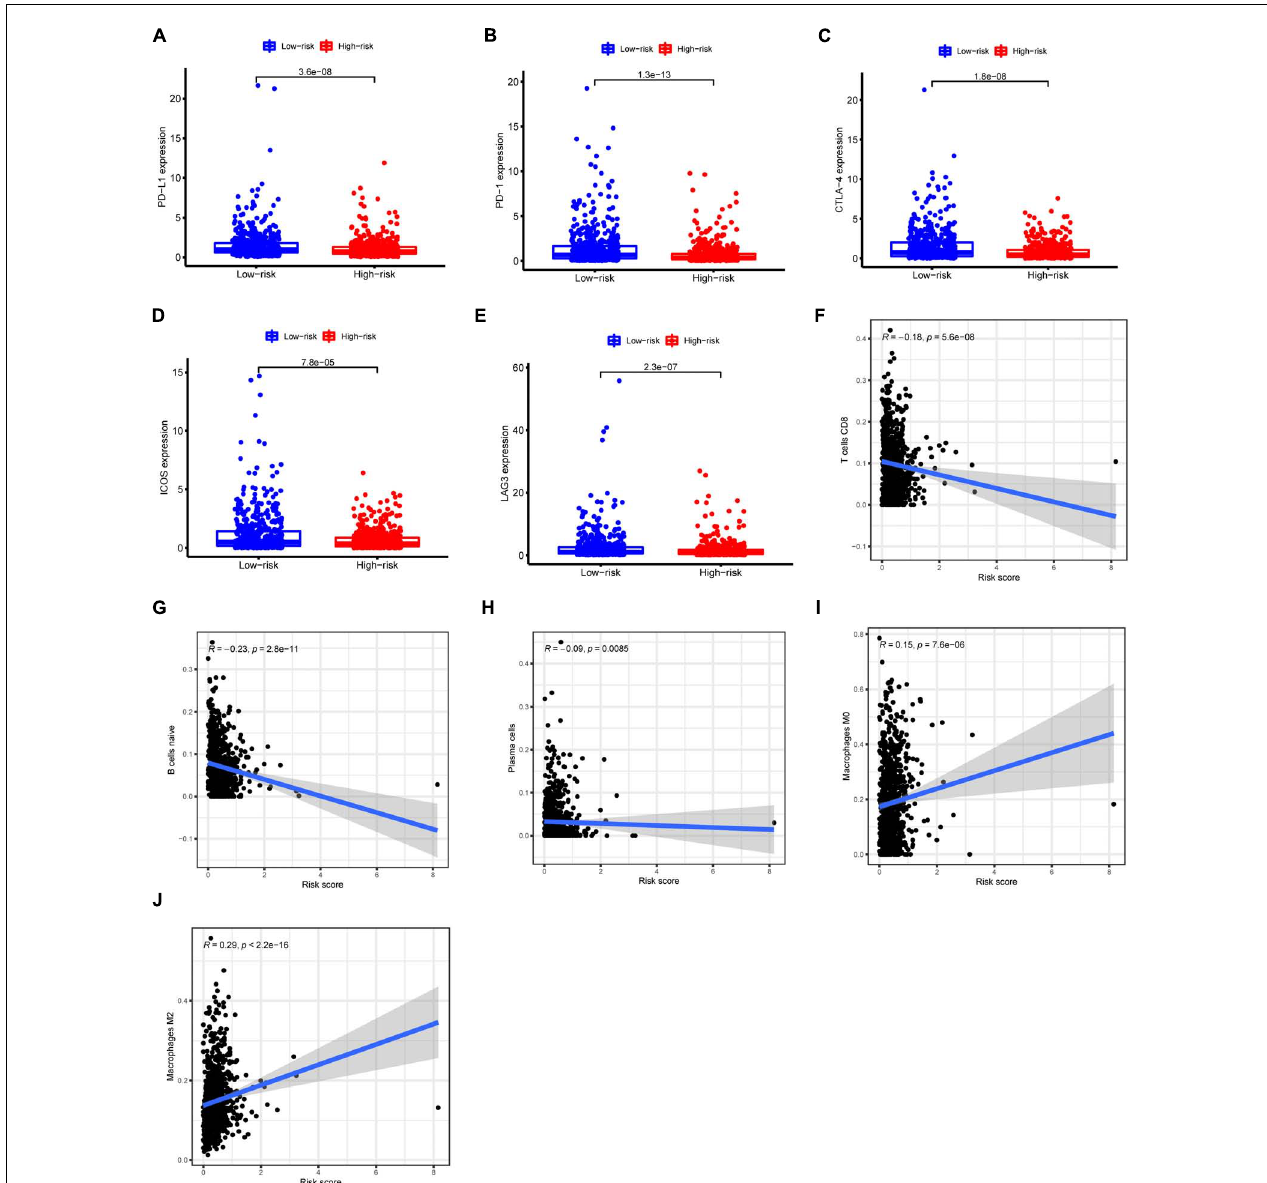
FIGURE 8 | Relationship of immune cell infiltration and the m6A-LncRM signature. (A–E) The expression of immune checkpoint members including PD-L1, PD-1, CTLA-4, ICOS, and LAG3 in low-risk and high-risk BC groups. (F–J) m6ALncM signature negatively related to CD8 T cells, naive B cells, and plasma cells, while positive relationships were observed between m6ALncM and M0 macrophages and M2